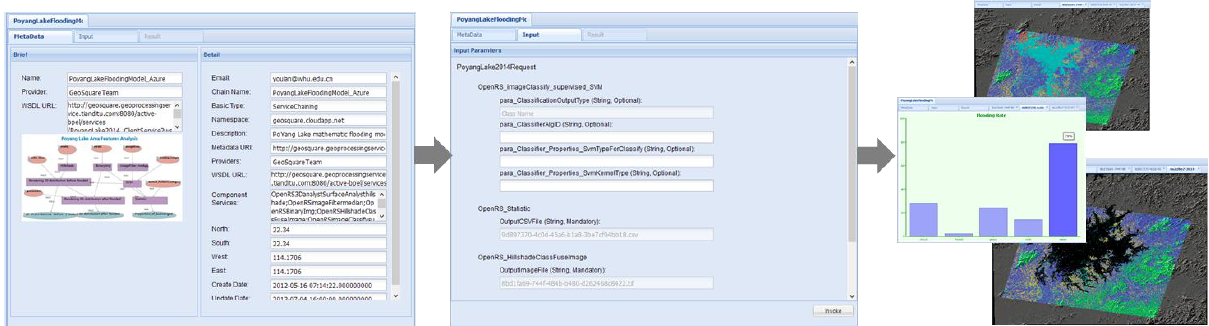
Figure 7 Full execution process of geoprocessing